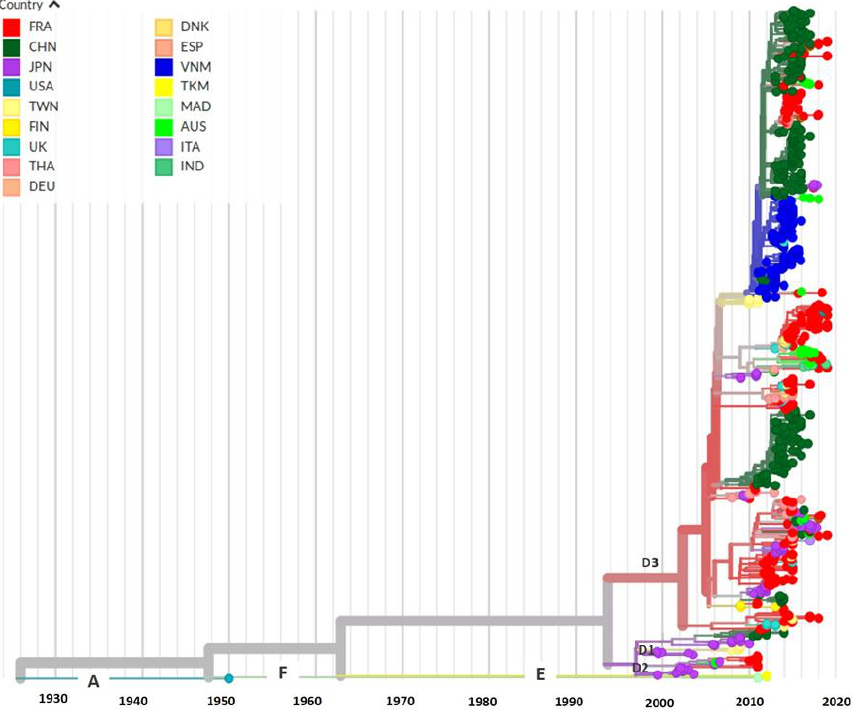
Figure 5. Chronogram and geographic distribution of CVA6 strains. Phylogenetic analysis was performed using the Nextstrain Augur toolkit [34].